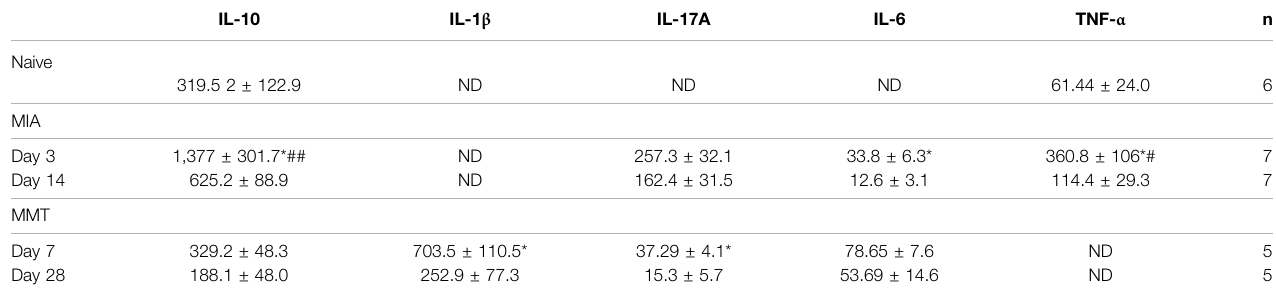
TABLE3| MeasurementofserumcytokinesinMIAandMMTanimals.SerumcytokinesIL-10,IL-1 β ,IL-17A,IL-6andTNF- α werequanti fi edinnaïveanimalsandduringearly and late timepoints in MIA and MMT animals. In both models, several cytokines were evelated during the early OA when compared to the late timepoint. * p < 0.05 denotes statistical signi fi cance comparing the two timepoints within the same model using a 1-way ANOVA. ## p < 0.01, # p < 0.05 compared to naïve control. Data presented as means ± SEM. ND, not